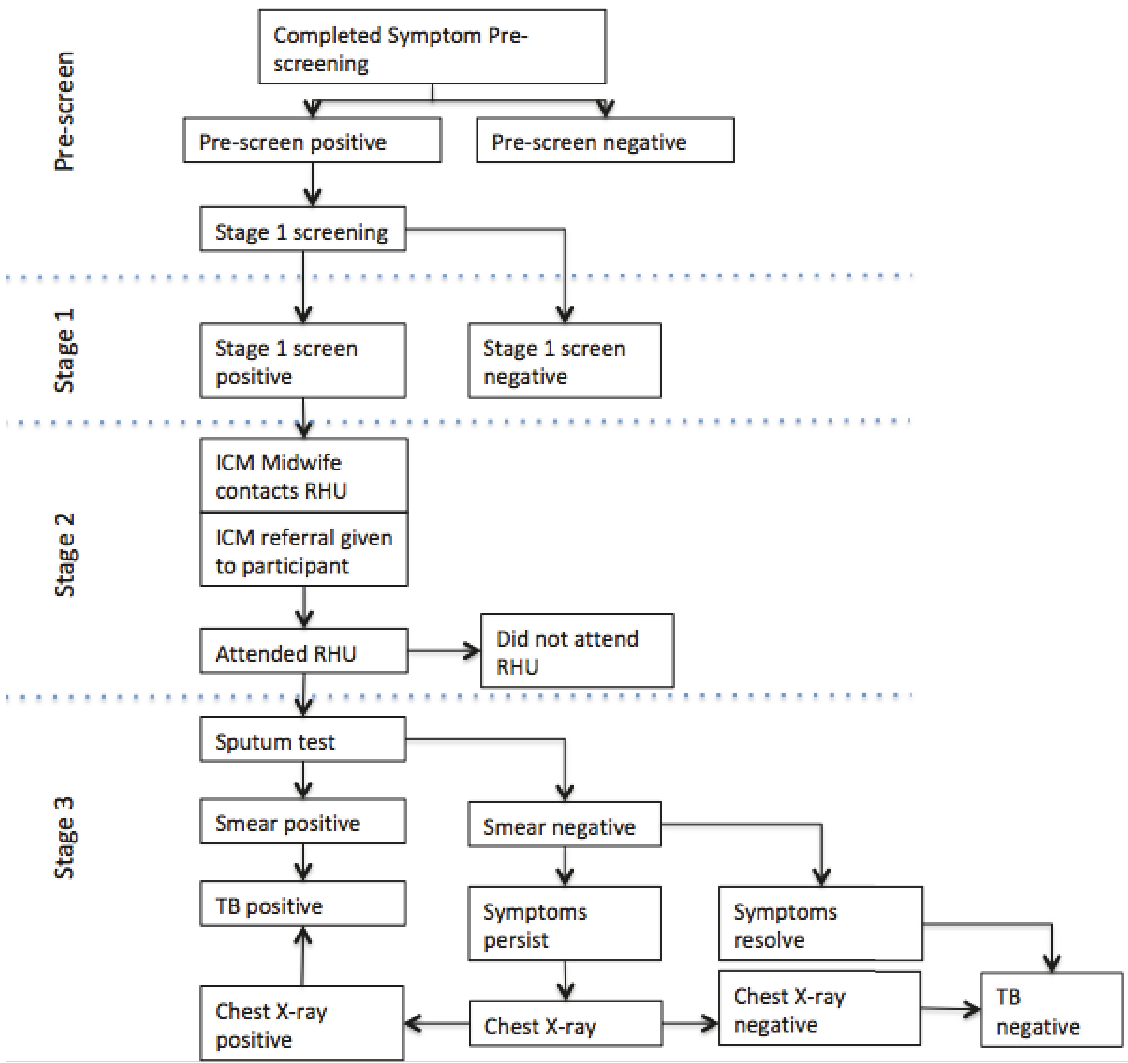
Figure 1: Flow chart of ICM TB Screening Program. Prescreening: over the course of 16 weeks, participants of ICM’s Transform program go throughpovertyalleviationlessons.ParticipantswereaskedaboutTBphysicalsymptomsatprescreening.Stage1:thosewhowereprescreened positive were asked again, the same questions, at this stage to filter out any false positive participants. Stage 2: ICM’s health trainers, local staff, who are fully capable of communicating in regional dialects, refer TB suspects to the closest rural health unit (RHU) for TB testing. This is where we monitored participants’ health-seeking behaviour through their decision to visit an RHU for testing or not. Stage 3: depending on the RHU, TB suspects are asked to provide a sputum sample and some would be required to have a chest X-ray taken for a more accurate